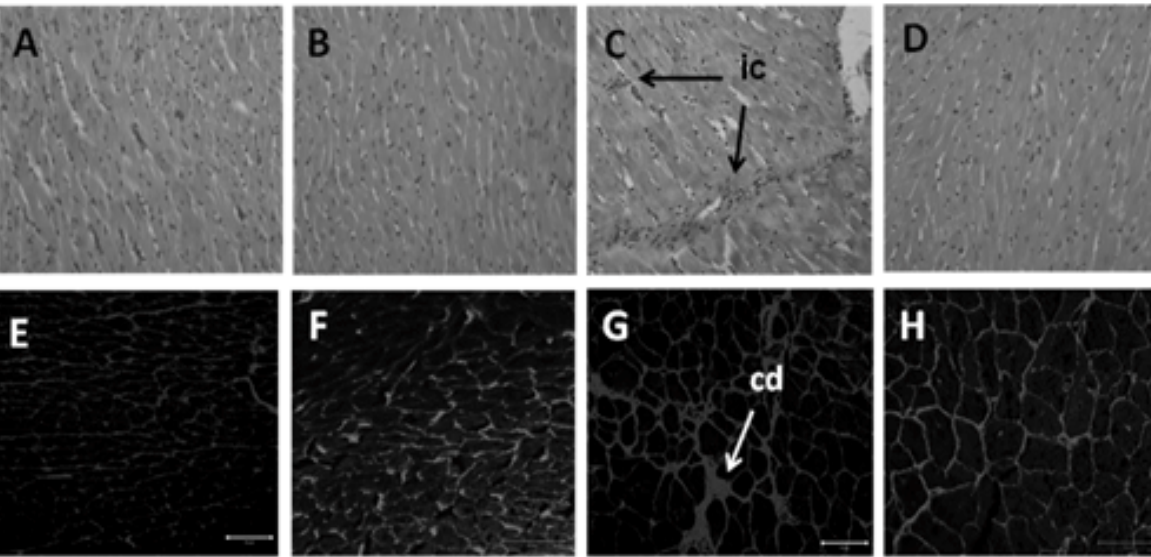
Figure 3. Haematoxylin and eosin staining of left ventricle (20×) showing inflammatory cells (marked as “ic”) as dark spots outside the myocytes in C ( A ), CT ( B ), H ( C ) and HT ( D ) diet-fed rats. Picrosirius red staining of left ventricular interstitial collagen deposition (40×) in C ( E ), CT ( F ), H ( G ) and HT ( H ) diet-fed rats; collagen deposition is marked as “cd”.